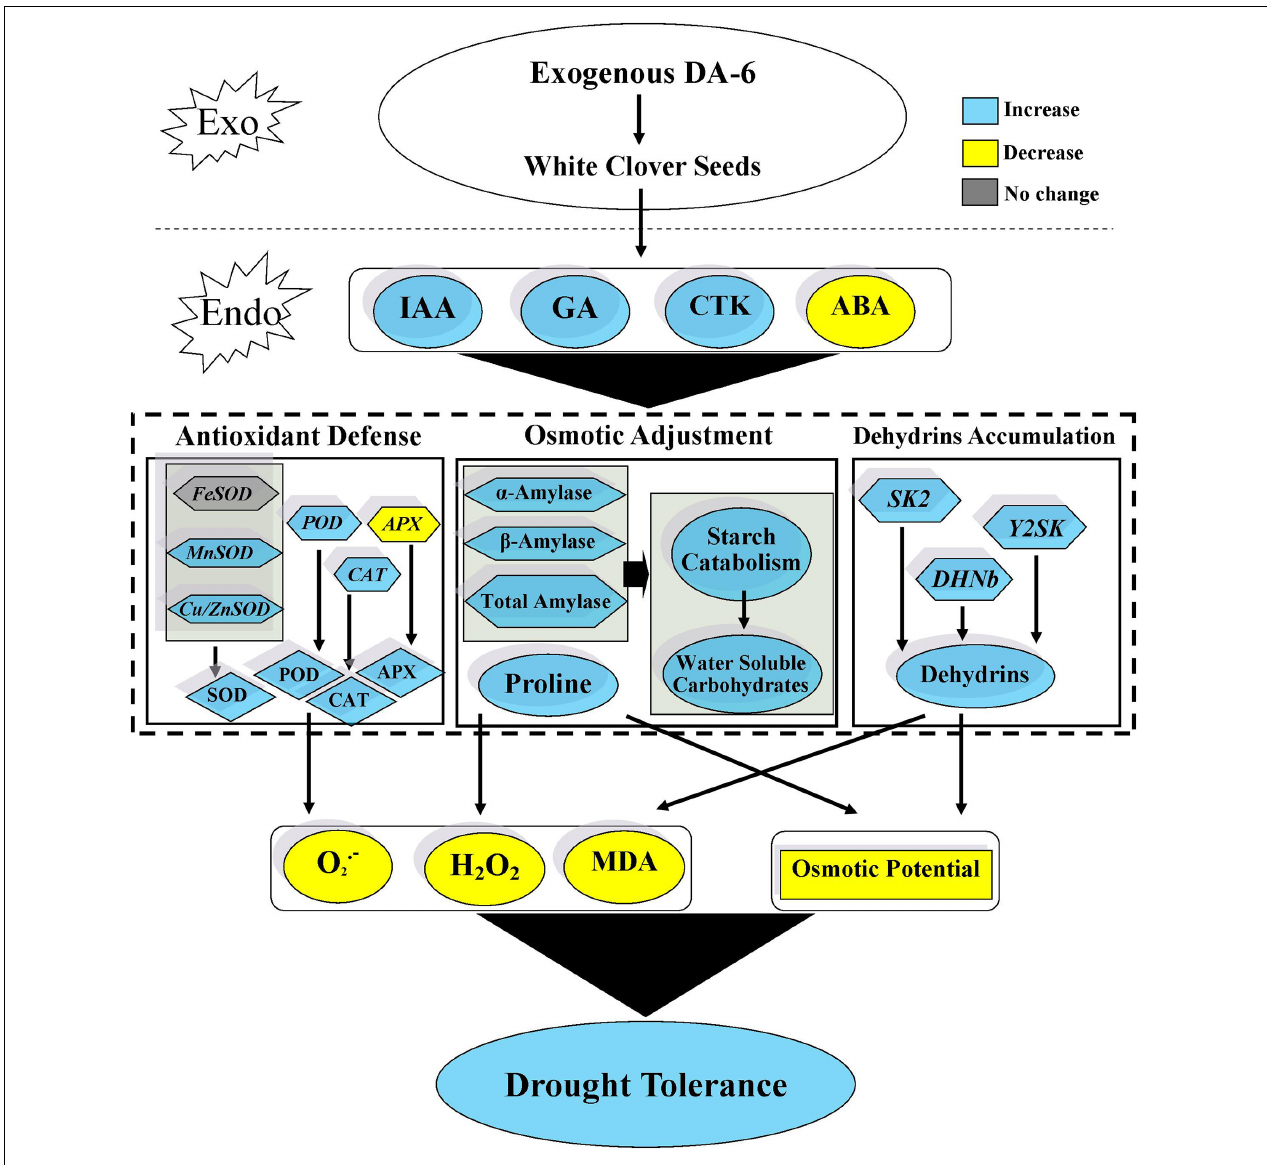
FIGURE 9 | Effect of DA-6 in white clover seed germination under drought